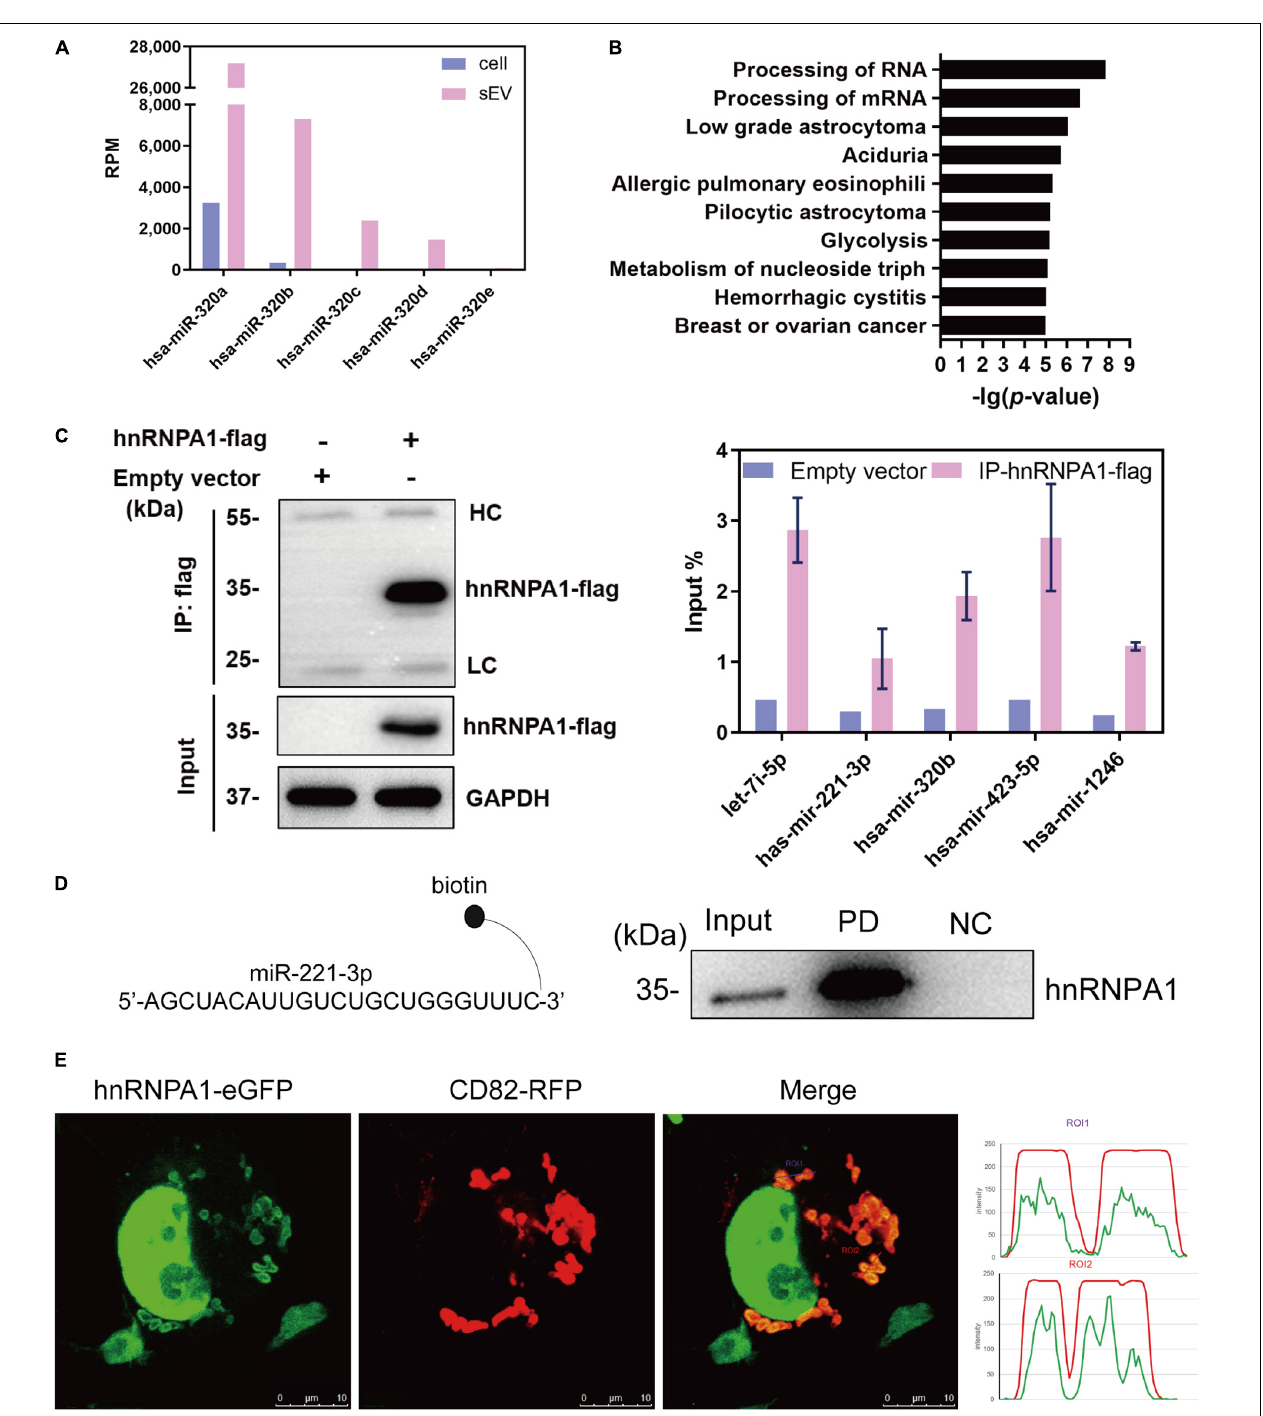
FIGURE 2 | HnRNPA1 is the optimal candidate RBP for sEV-miRNA loading. (A) RPM of miR-320 family in cells and sEVs according to small RNA sequencing data. (B) Ingenuity Pathway Analysis (IPA) analysis of the 70 precipitated proteins identified by MS. Ten of the most associated pathways are shown. (C) Results of RNA immunoprecipitation experiments using anti-flag magnetic beads to pull down hnRNPA1-flag fusion protein, western blotting analysis of pull-down hnRNPA1-flag (left), and RT-qPCR analysis of co-precipitated miRNAs (right). HC, heavy chain. LC, light chain. Three independent experiments were performed. (D) Western blotting analysis of hnRNPA1 in the pull-down complex co-precipitated with biotin-labeled miR-221-3p. NC, negative control (beads + control miRNA without biotin). PD, pull-down (beads + biotin-labeled miR-221-3p). (E) The confocal images of RFP-labeled CD82 and eGFP-labeled hnRNPA1 in a representative A549 cell. Co-localization was analyzed in 24 cells and visualized by ImageJ software. Bars = 10 µ m. hnRNPA1, heterogeneous nuclear ribonucleoprotein A1; RBP, RNA-binding protein; sEV-miRNA, microRNA in small extracellular vesicle; RPM, reads per million.